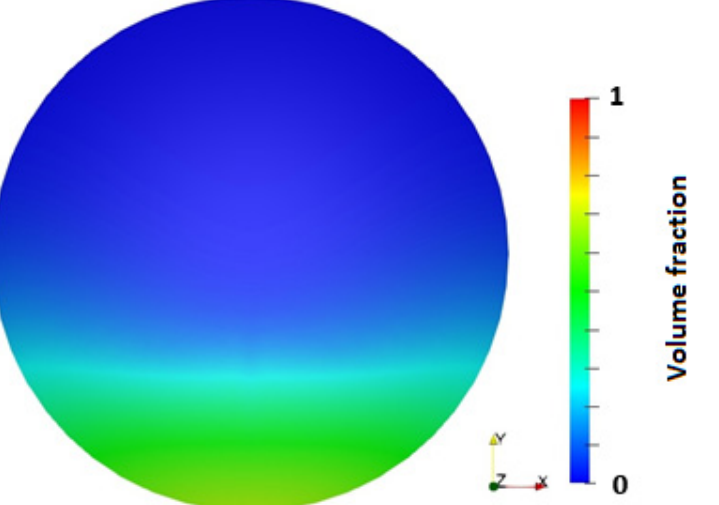
Figure 12. Distribution of water volume fraction across pipe section for test 4 (mixture velocity = 1 m/s, water cut = 0.1).